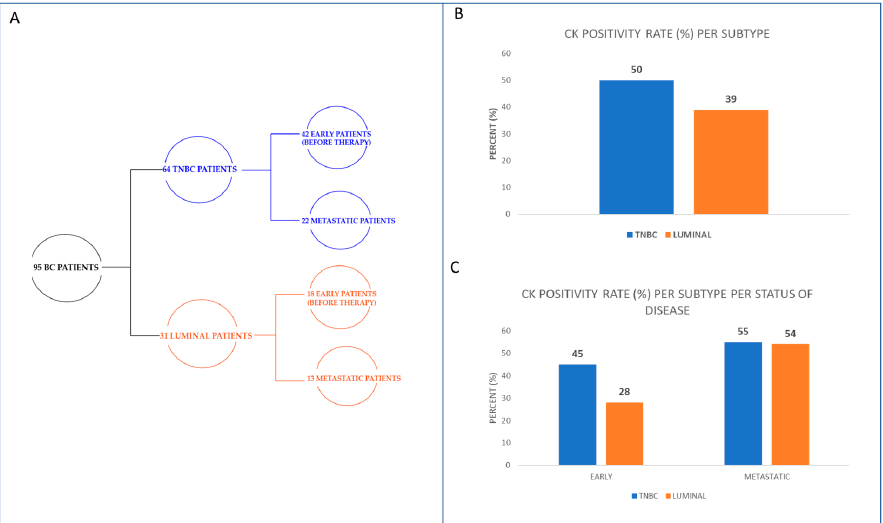
Figure 1. Study design and CTCs’ positivity rate in TNBC and luminal BC patients. ( A ) Flowchart showing the total number of BC patients categorized in the two major subtypes (luminal and TNBC) and their disease status (early and metastatic). ( B ) Percentage of CK+ TNBC and luminal patients. ( C ) Percentage of CK+ early and metastatic TNBC and luminal patients.